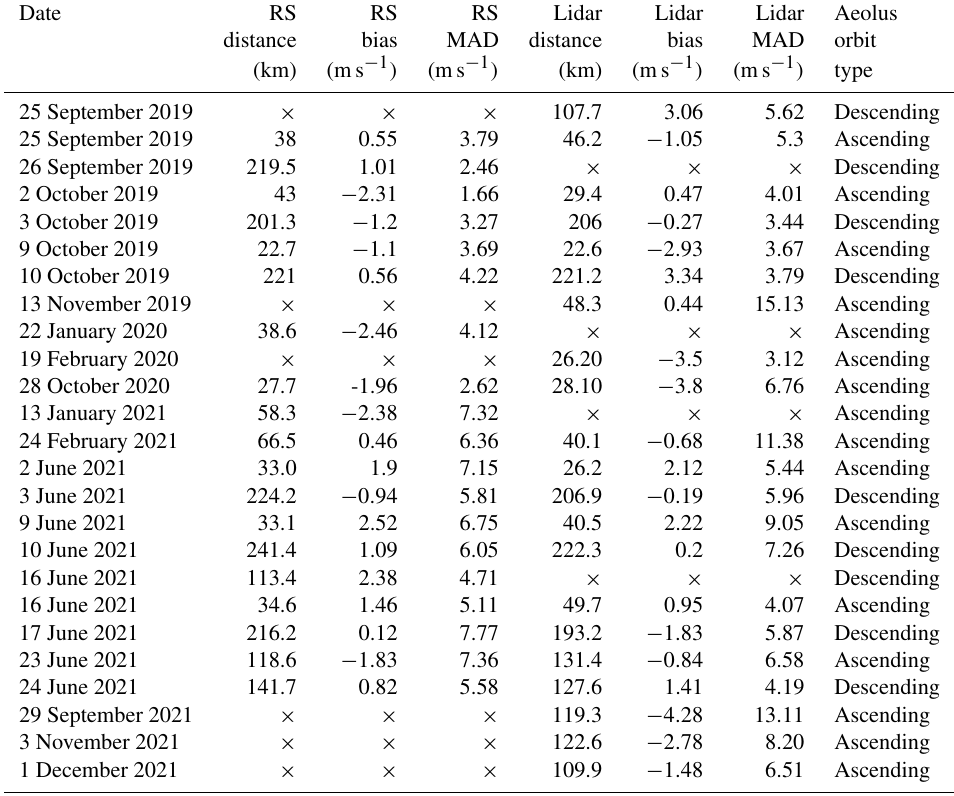
Table 1. Overview of the complete list of AboVE-Maido-1 and 2 Aeolus overpass collocations. The cases of single collocations are also included. The distance is calculated over the average position of each instrument. A more detailed table is provided in the